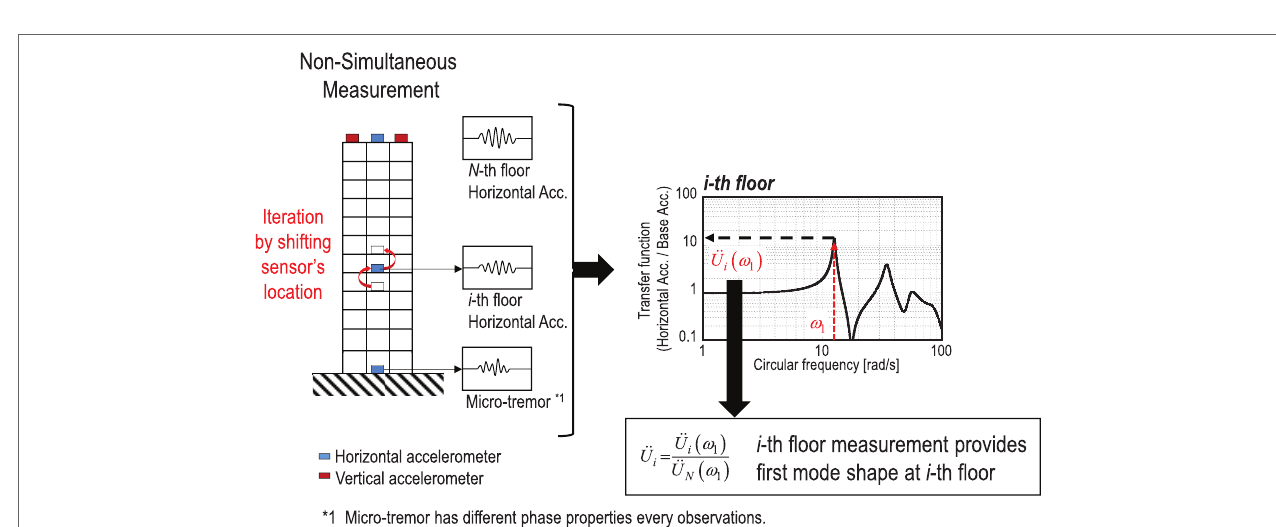
FIGURE 2 | Schematic diagram of lowest-mode shape identification based on transfer functions.